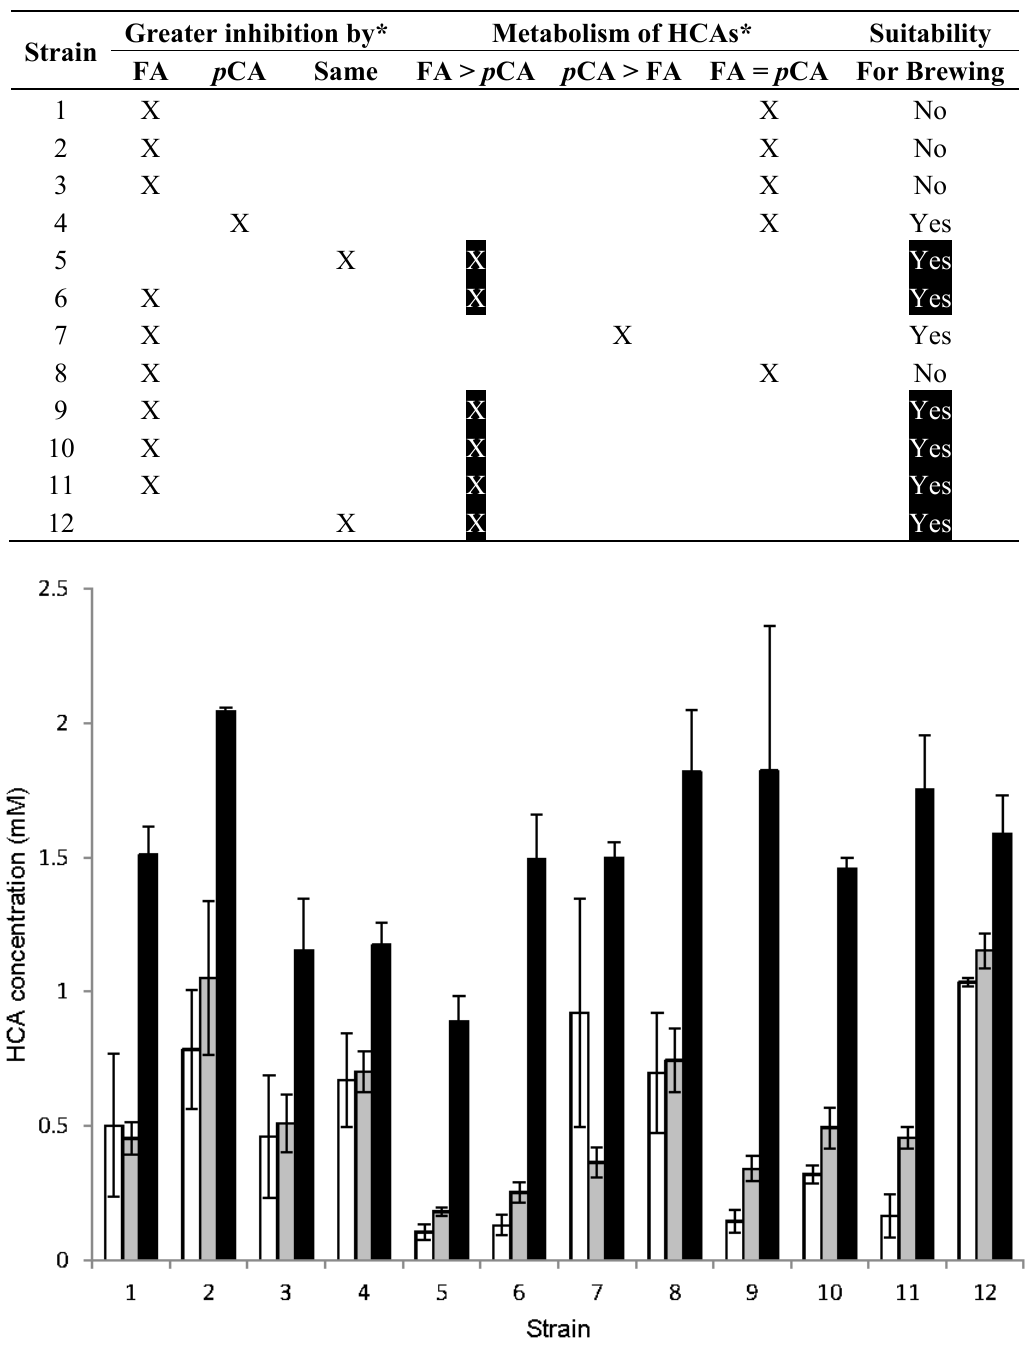
Figure 2. Metabolism of hydroxycinnamic acids (HCA) by yeast strains. Strains were incubated in MYPG supplemented with 2 mM HCA. The concentration of HCA remaining after 14 days was determined by measuring the absorbance at 313 nm (ferulic acid and caffeic acid) or 287 nm ( p -coumaric acid) compared to the absorbance of a sample incubated without added cells. White bars, ferulic acid; gray bars, p -coumaric acid; black bars, caffeic acid. Graph represents mean plus standard error of the